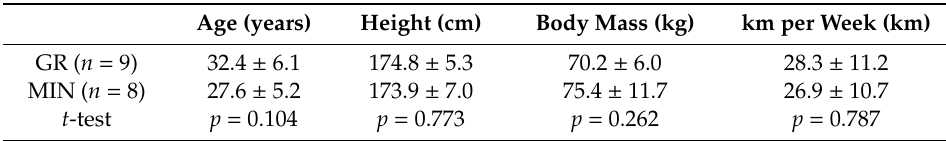
Table 2. Information of the participants who completed training. GR: gait retraining + minimalist shoe, MIN: minimalist shoe.